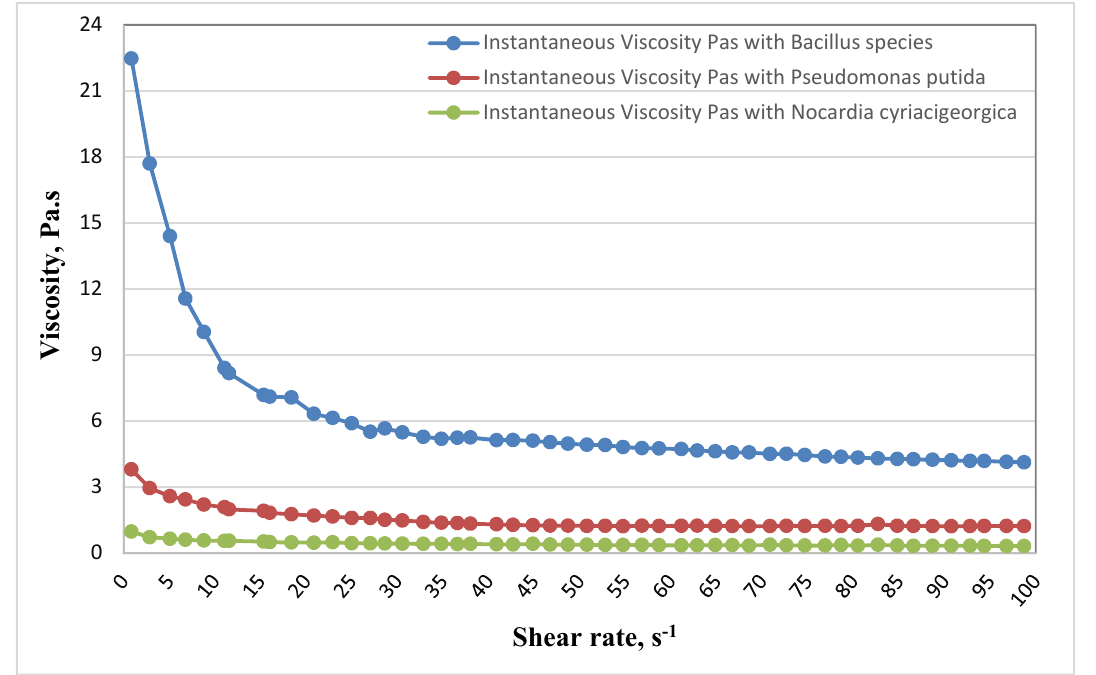
Figure 1. Reduction in viscosity of crude oil treated with Bacillus species, Pseudomonas putida , and Nocardia cyriacigeorgica at 37°C